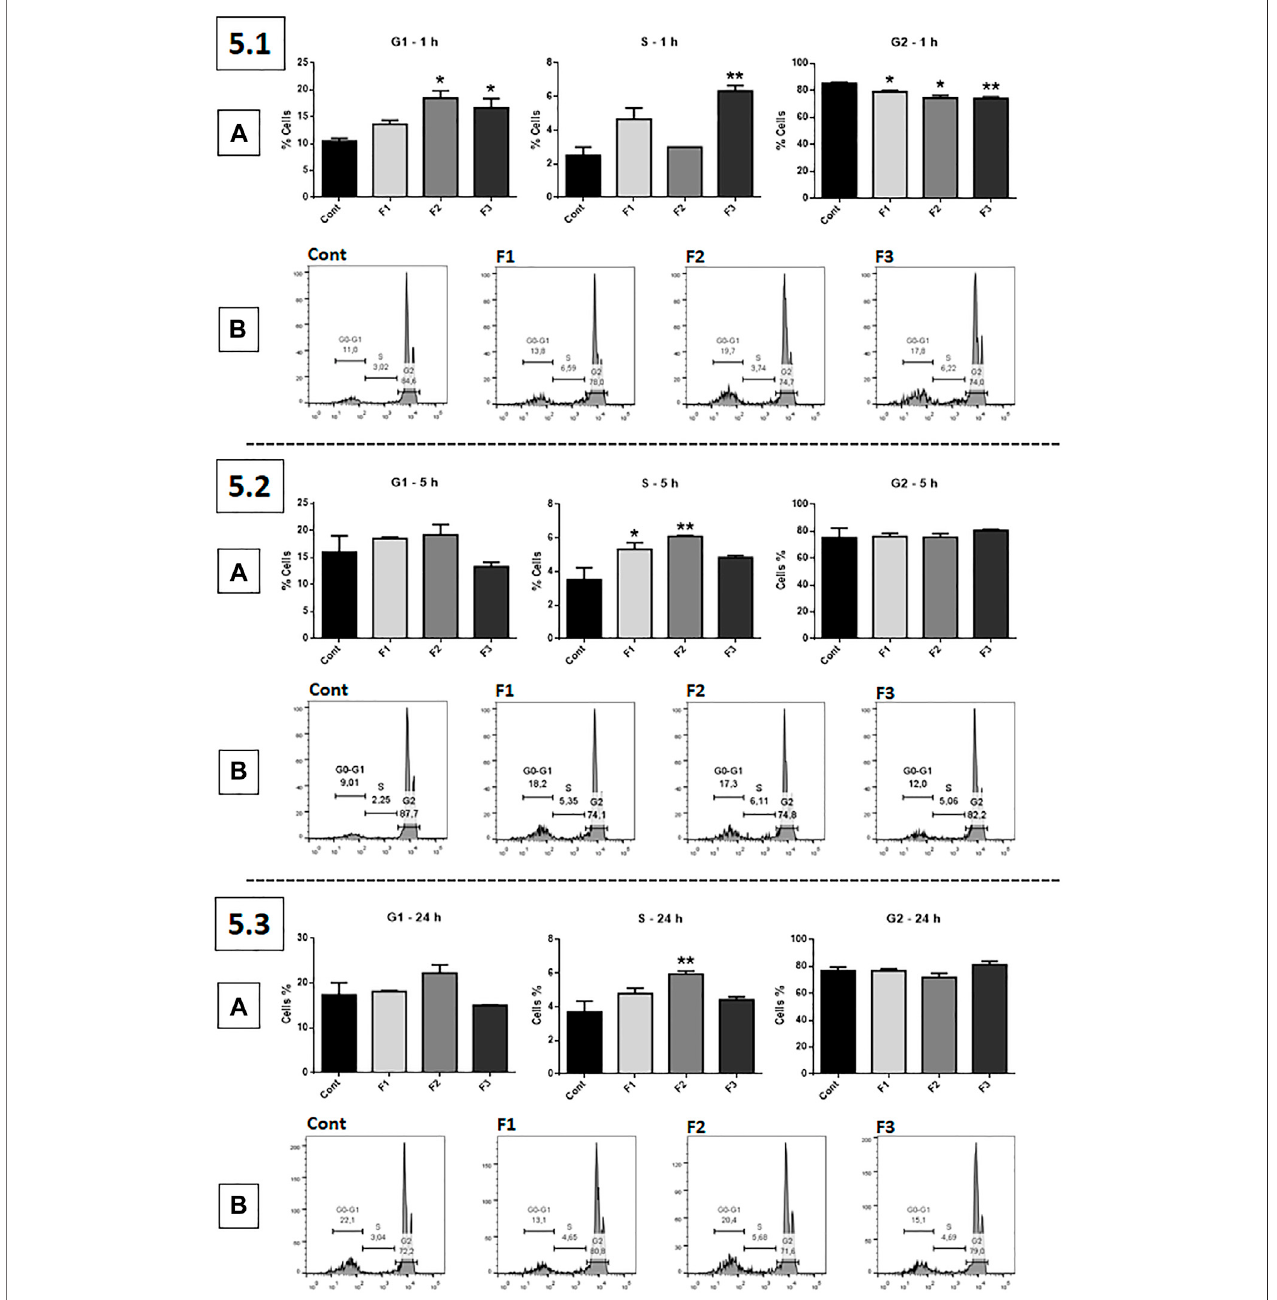
FIGURE 5 | Cell cycle assessed by propidium iodide (PI): human GB cells treated with F1, F2, and F3 at 0.1 μ g/ml 5.1 (A) After 1 h of treatment, F2 and F3 signi fi cantlyincreasedthenumberofGBcellsintheG1phaseofthecellcycle compared totheuntreated control, while F3accumulatedcellsintheSphase; allfractions signi fi cantlydecreasedthepercentageofcellsintheG2phase.5.2 (A) After5 hoftreatment,F1andF2signi fi cantlyincreasedthenumberofcellsintheSphase.5.3 (A) After 24 h of treatment, only F2 signi fi cantly increased the number of cells in the S phase. (B) 5.1, 5.2 and 5.3 show representative histograms. One-way ANOVA followed by Dunnett ’ s multiple comparisons test; unpaired Student ’ s t-tests were used to compare each treatment with the control. * p < 0.05, ** p < 0.01, compared to the control (Cont).